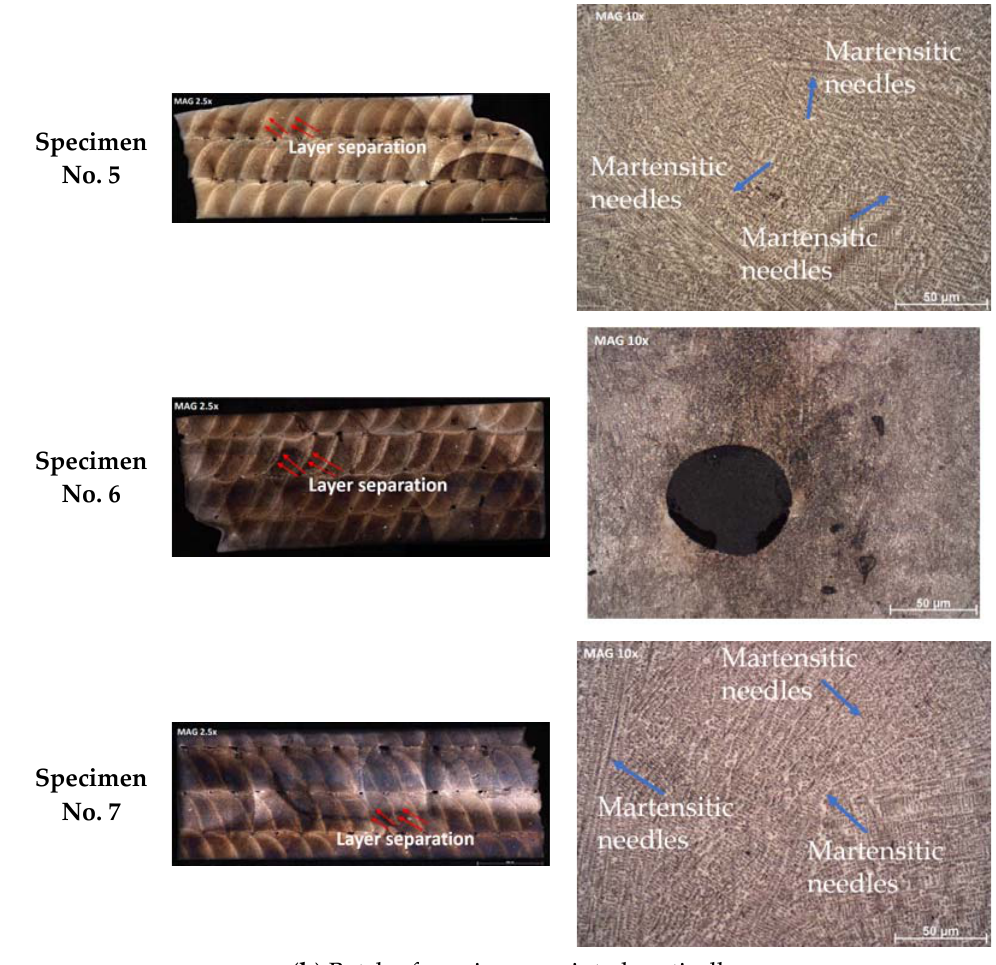
Figure 19. Microstructure of different batches of samples prepared by 3D printing method in various orientations, including ( a ) horizontal direction and ( b ) vertical direction.